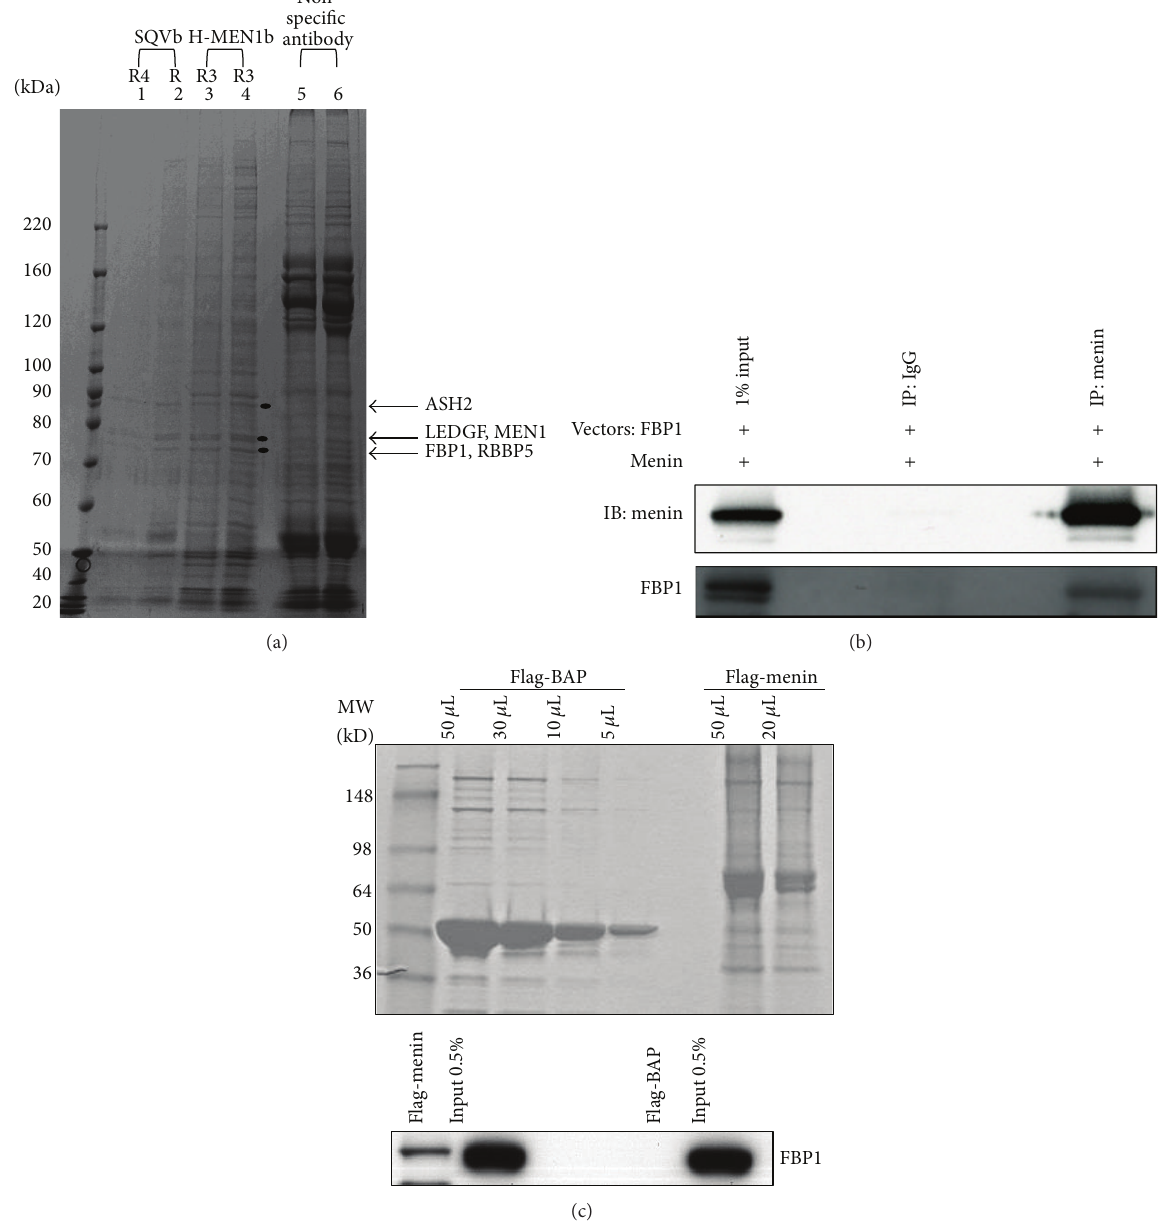
Figure 1: Menin interacts with FBP1. (a) Menin was immunoprecipitated from HeLa nuclear extract using either SQVb antibody (lanes 1 and 2) or H-MEN1b antibody (lanes 3 and 4). An antibody not related to menin (lanes 5 and 6) was included as a negative control. The arrows and black circles indicate ASH2, LEDGF, MEN1, FBP1, and RBBP5. (b) Menin (goat antibody from Bethyl) was immunoprecipitated from whole cell extracts prepared from HEK293 cells transfected with menin and FBP1 plasmids. Immunoblot analysis was performed to detect menin and FBP1. IgG was included as a negative control. (c) (upper panel) Coomassie blue staining of Flag-BAP and Flag-menin immunoprecipitates after production and purification from bacterial cells. (lower panel) Equal concentrations of Flag-menin and Flag-BAP were used to precipitate FBP1 from HEK293 cells transfected with FBP1 plasmid. Immunoblot analysis was performed for FBP1.